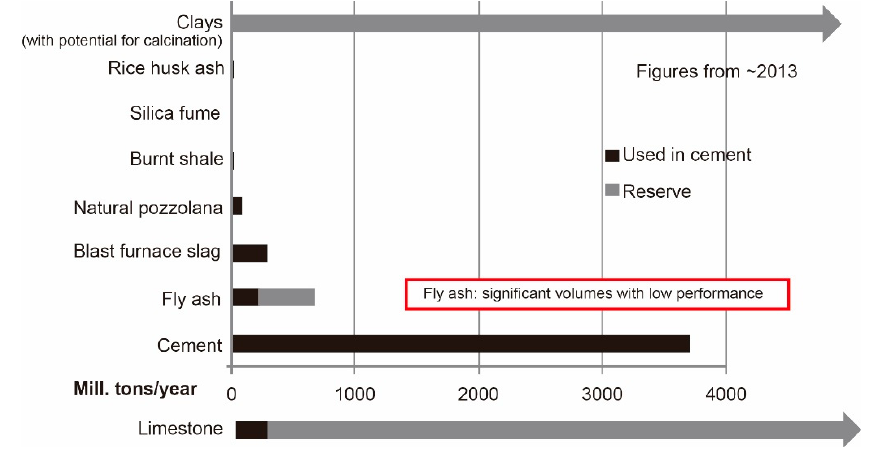
Figure 1. Quantities of common supplementary cementing materials (SCMs). Reproduced from: Scrivener et al. [16].